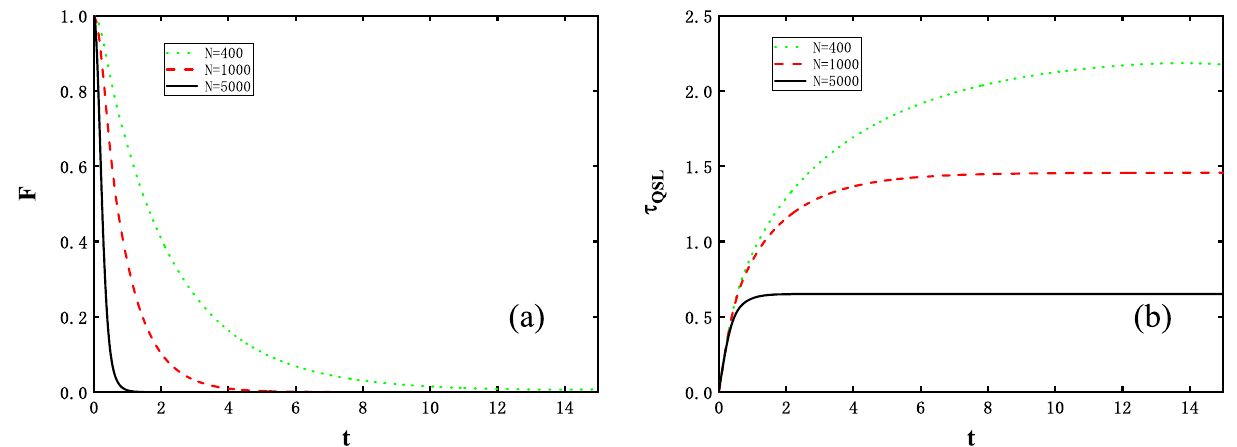
Figure 1. Time in units of 1/ J , evolution of ( a ) the fidelity F and ( b ) the QSL time τ QSL , with system size N = 400 (green dotted line), 1000 (red dashed line), and 5000 (black solid line). The external magnetic intensity, anisotropy value, and coupling constant set as (cid:31)